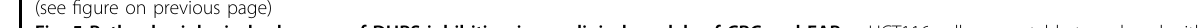
Fig. 5 Pathophysiological relevance of DHPS inhibition in preclinical models of CRC and FAP. a HCT116 cells were stably transduced with lentiviruses expressing DHPS (shRNA) or nonspeci fi c shRNAs (SCR) and then implanted subcutaneously into CD1 nude mice (2 × 10 6 cells each fl ank). Tumors were measured starting when they reached an average volume of 100 mm 3 . (SCR n = 6; shDHPS n = 6). b Representative images of explanted masses from a at the end of the procedure. c Average tumor weight of the explanted masses from a . d Hyp-EIF5A, Ki67, or hematoxylin staining of tumor sections from explanted masses shown in b . Scale bar 100 μ M. e HCT116 cells were implanted subcutaneously into CD1 nude mice (2 × 10 6 cells each fl ank). When tumors reached an average volume of 100 mm 3 , mice were treated i.p. with GC7 4 mg/kg or control vehicle. Tumor volumes were measured at the indicated days. (CTRL n = 8; GC7 n = 8). f Representative images of explanted masses from e at the end of the experiment (CTRL vs. GC7). g Average tumor weight of the explanted masses from e at the end of the procedure. h Hyp-EIF5A, Ki67, or hematoxylin staining of tumors from f . Scale bar 100 μ M. i Protocol of AOM (12 mg/kg) and GC7 (25 mg/kg) treatments in APC Min/ + mice. j Left, number of polyps ≥ 2 mm in size in the small intestine of female APC Min/ + mice treated with GC7 ( n = 3) or CTRL ( n = 3) as shown in i . Right, representative image of the polyps. Scale bar 1 mm. k Western blot analysis of MYC, Hyp-EIF5A, EIF5A, and β -actin (loading control) levels in pooled extracts from polyps in the small intestine of APC Min/ + mice treated as in i . Control, n = 3; GC7, n = 3. Schematic Model. Hypusinated EIF5A (Hyp-EIF5A) promotes MYC elongation by alleviating ribosome stalling at fi ve pausing motifs. By regulating transcription of the enzyme Ornithine decarboxylase (ODC), MYC promotes an increase of the three polyamines (PUT, SPD, SPM). Elevations of SPD content lead to increased Hyp-EIF5A, thereby sustaining an ampli fi cation feedback loop. Inhibition of this mechanism limits intestinal tumor